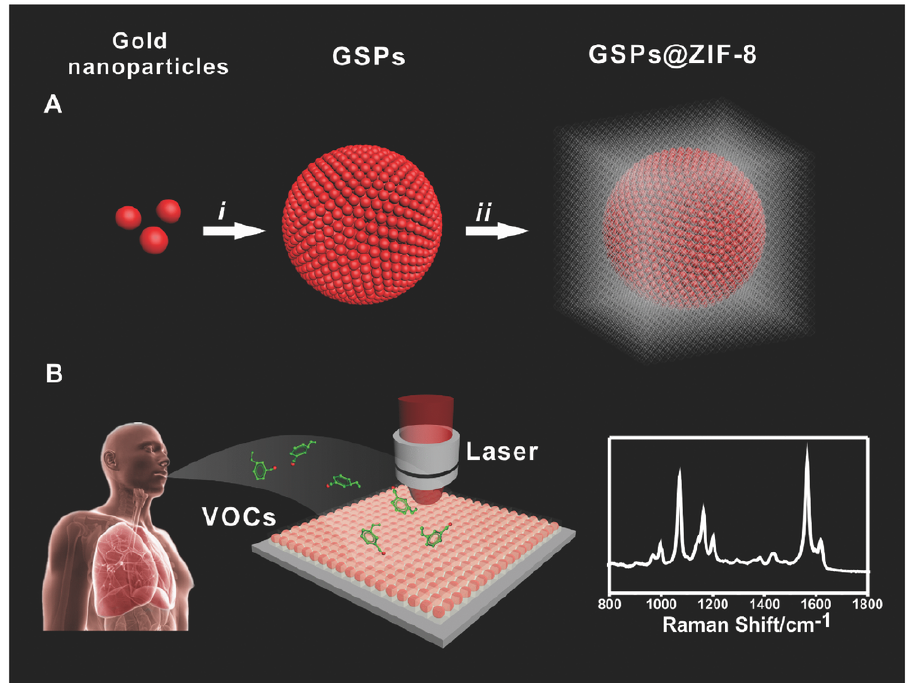
Figure 4. ( A ) Synthetic route for GSP@ZIF-8 3D core–shell. i. Aggregation of gold nanoparticles (AuNPs) to form spherical GSP. ii. GSP surface-coated with ZIF-8 shell. ( B ) Exhaled breath capture